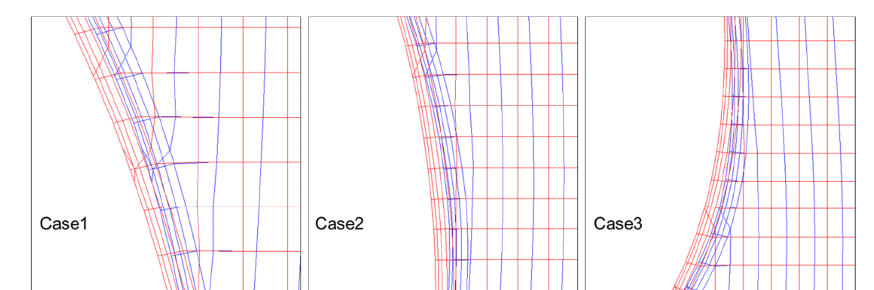
Figure 9. Deformed hull shapes.